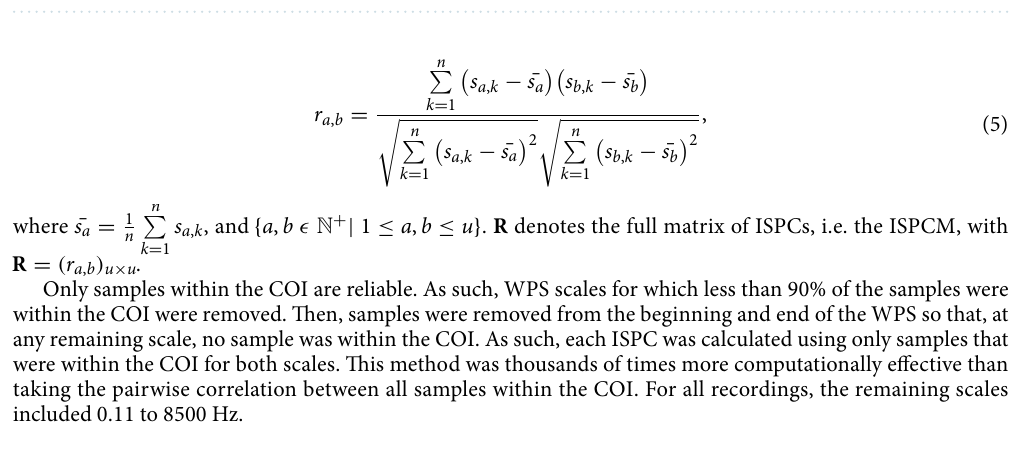
Figure 9. Diagram of pre- and post-processing data flow for the neural